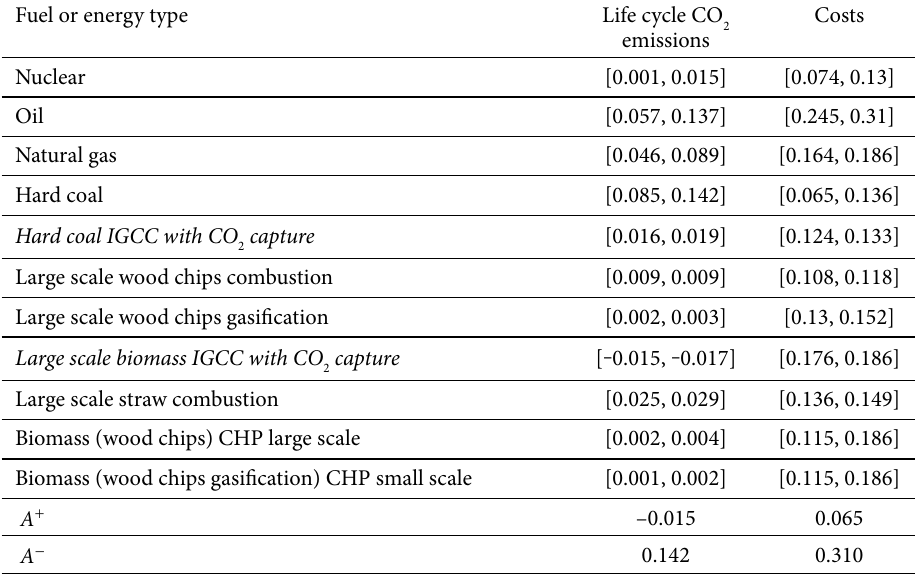
Table 3. The normalized interval decision